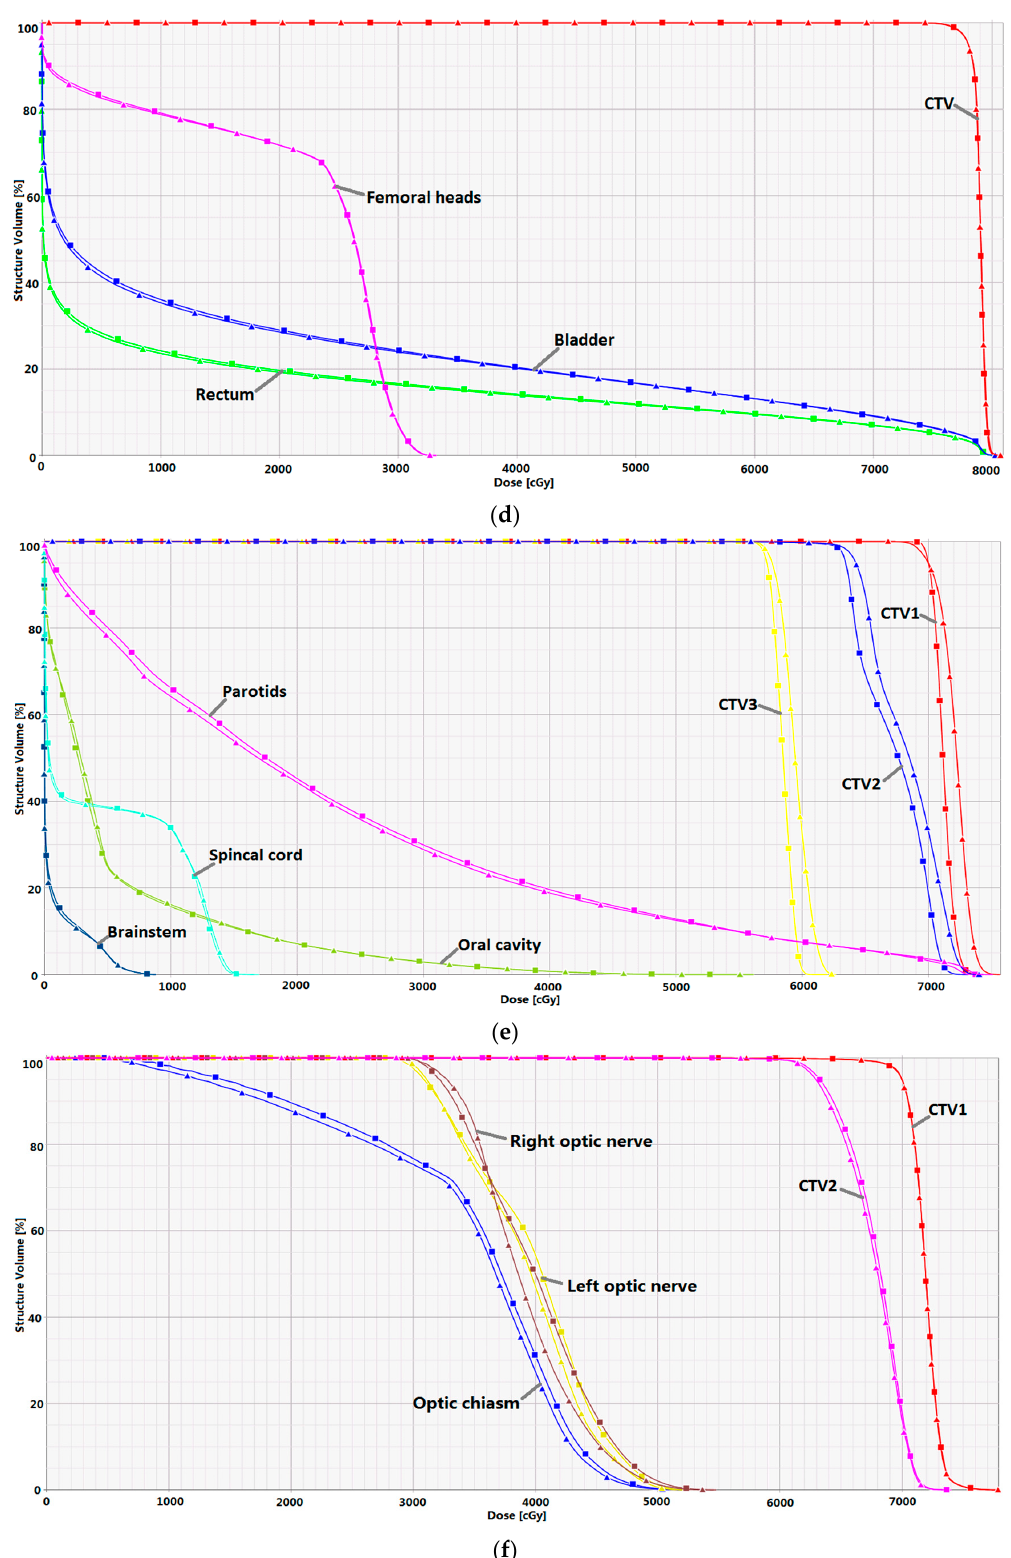
Figure 4. Dose-volume histograms with IMRF (line with squares) and without IMRF (line with triangles). ( a ) scalp case; ( b ) brain case; ( c ) lung case; ( d ) prostate case; ( e ) head and neck (H & N) case; and ( f ) base of skull (BOS) case. CTV, clinical target volume.